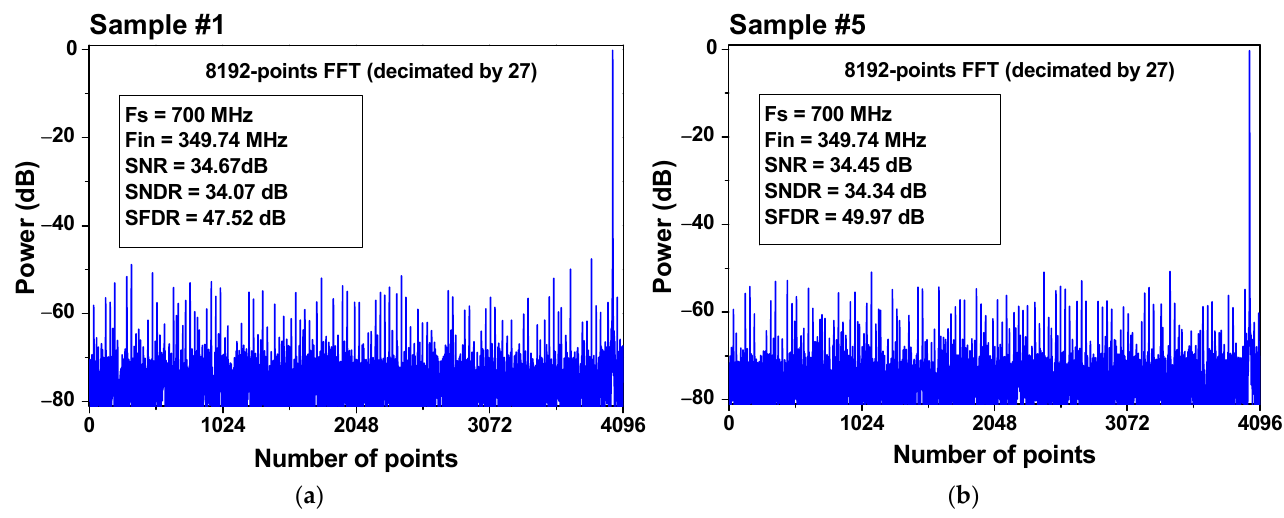
Figure 13. Measured FFT spectrums with a 349.74 MHz input at a 700 MS/s sampling rate. ( a ) Sam- ple #1. ( b ) Sample #5.